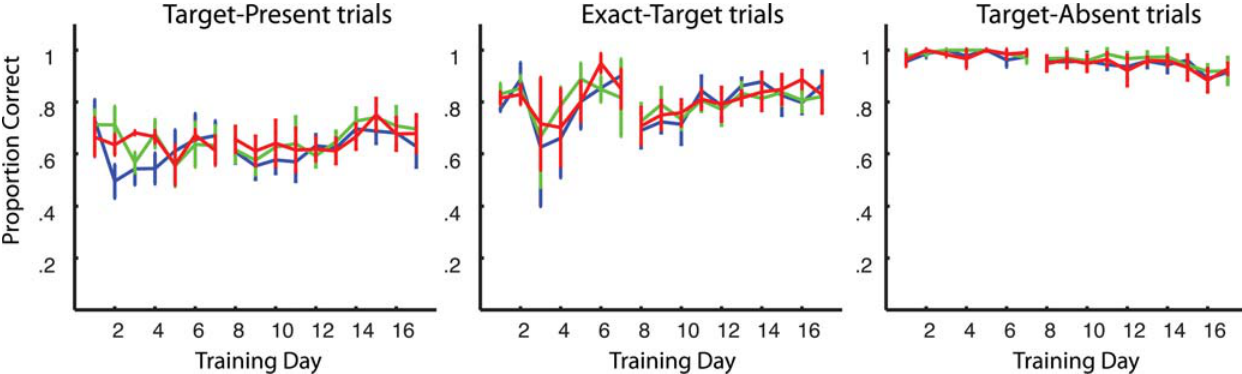
Figure 3. Results from the RSVP task performed during the training sessions. Plots represent data from target-present (left), exact-target (middle) and target-absent (right) trials, respectively. The break in the lines represents that the data from the first 7 days are from 3 subjects and that of last 10 days are from all 7 subjects. Each line represents trials in which a different direction was presented; exact-target direction (blue), target- present direction (green), target-absent direction (red). Error bars represent within-subject standard error [20]).